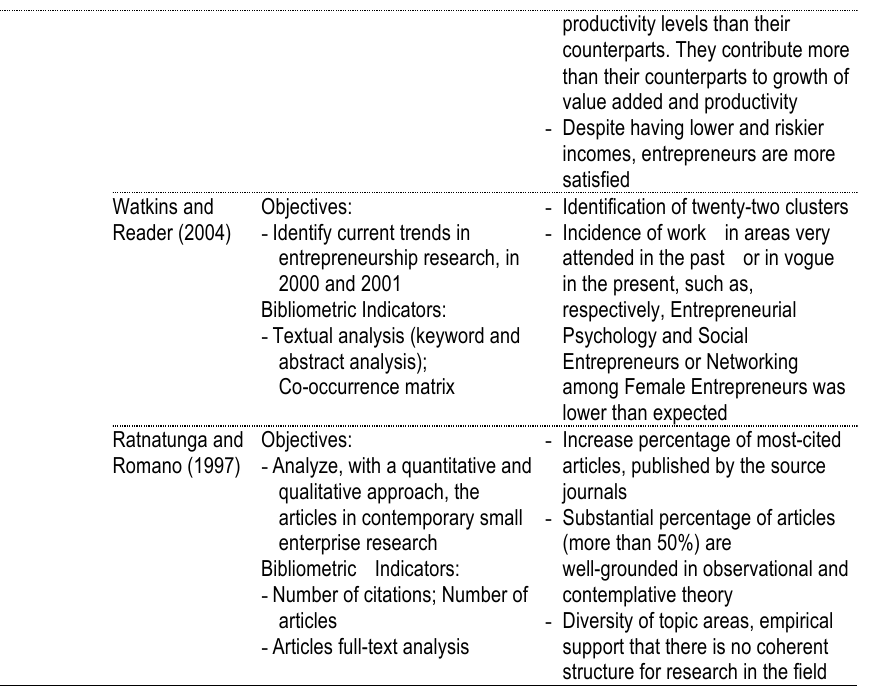
Table A1c : Bibliometric studies – Research Intellectual Structures Application Areas - Research Intellectual Structures